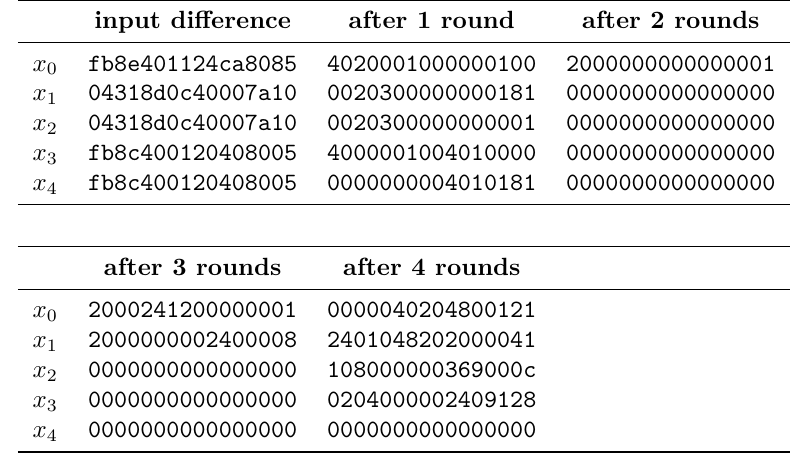
) is [82 , 32 , 4 , 23]. 2